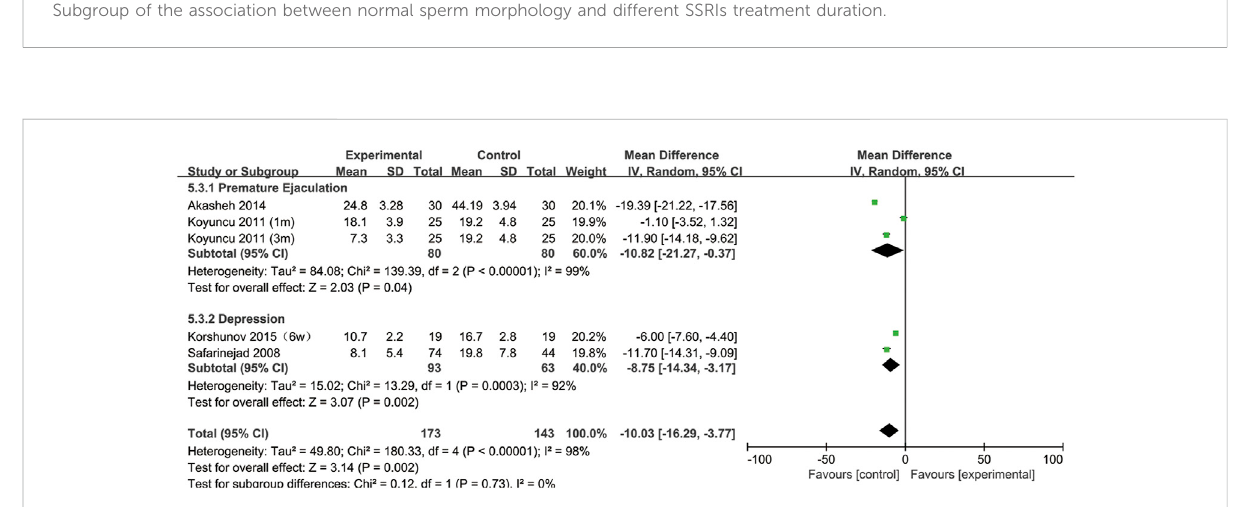
Subgroup of the association between normal sperm morphology and different SSRIs treatment duration.